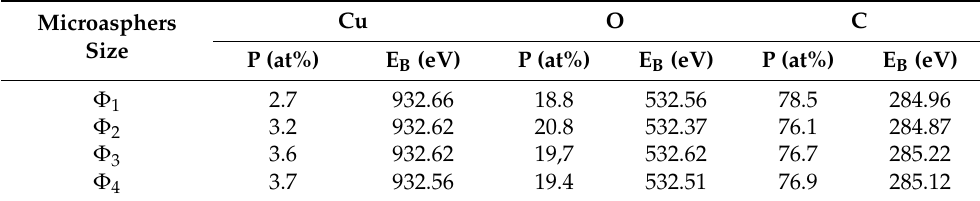
Table 2. Percentage (P) of copper, oxygen and carbon with an indication of the binding energy (E) of photoelectrons derived from these